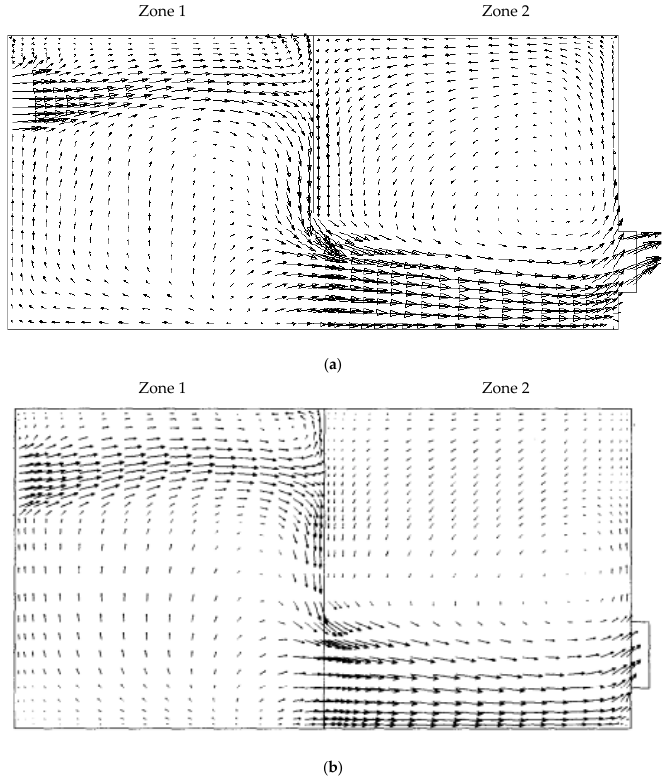
Figure 8. Comparison of the air flow patterns in the mid-plane: ( a ) present study, ( b ) Lu et al..